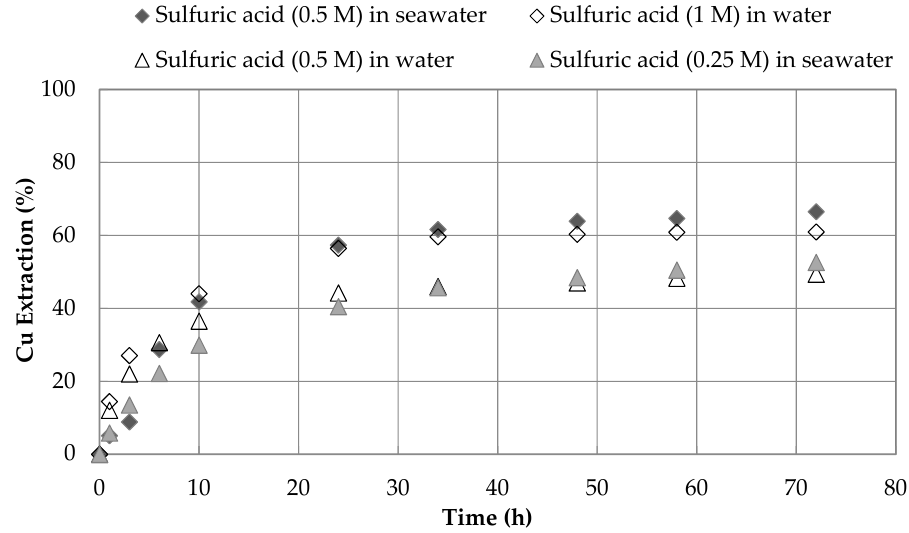
Figure 5. Copper extraction in the leach liquors with experimental conditions of: NaNO 3 (1 M), 3 days of leaching, 45 °C.